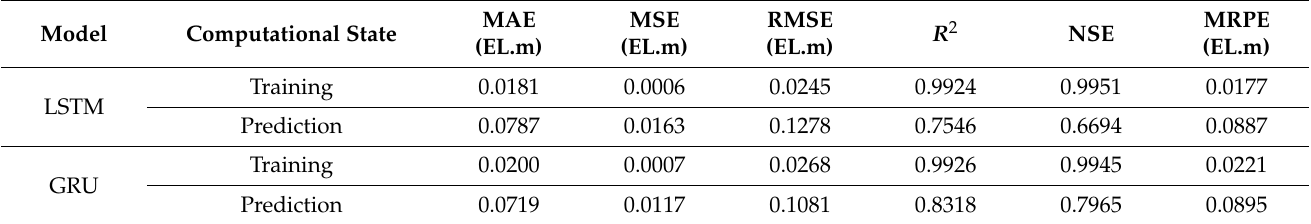
Table 9. Comparison of bivariate model